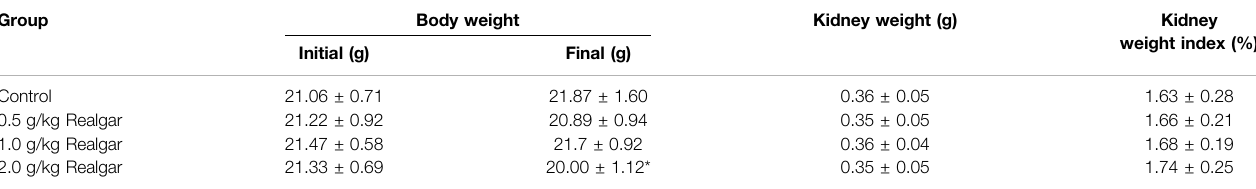
TABLE 1 | Effect of Realgar on body weight and kidney index of control and experimental animals.